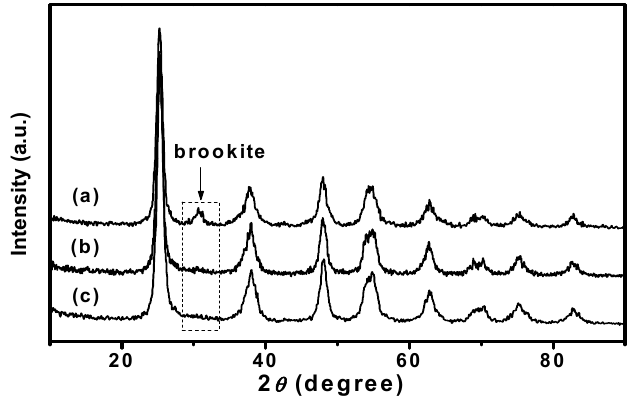
Figure 1. Patterns for (a) MTiO 2 /Ala, (b) MTiO 2 /DDA, and (c) MTiO 2 /Ala-DDA.